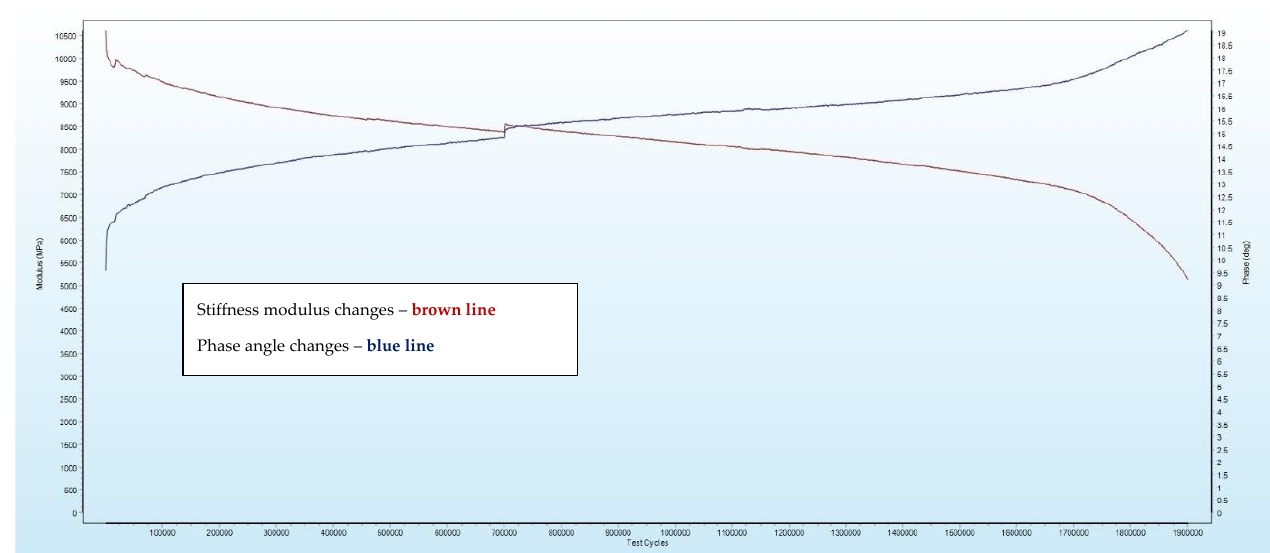
Figure 7. Exemplary sample result registered by testlab software.